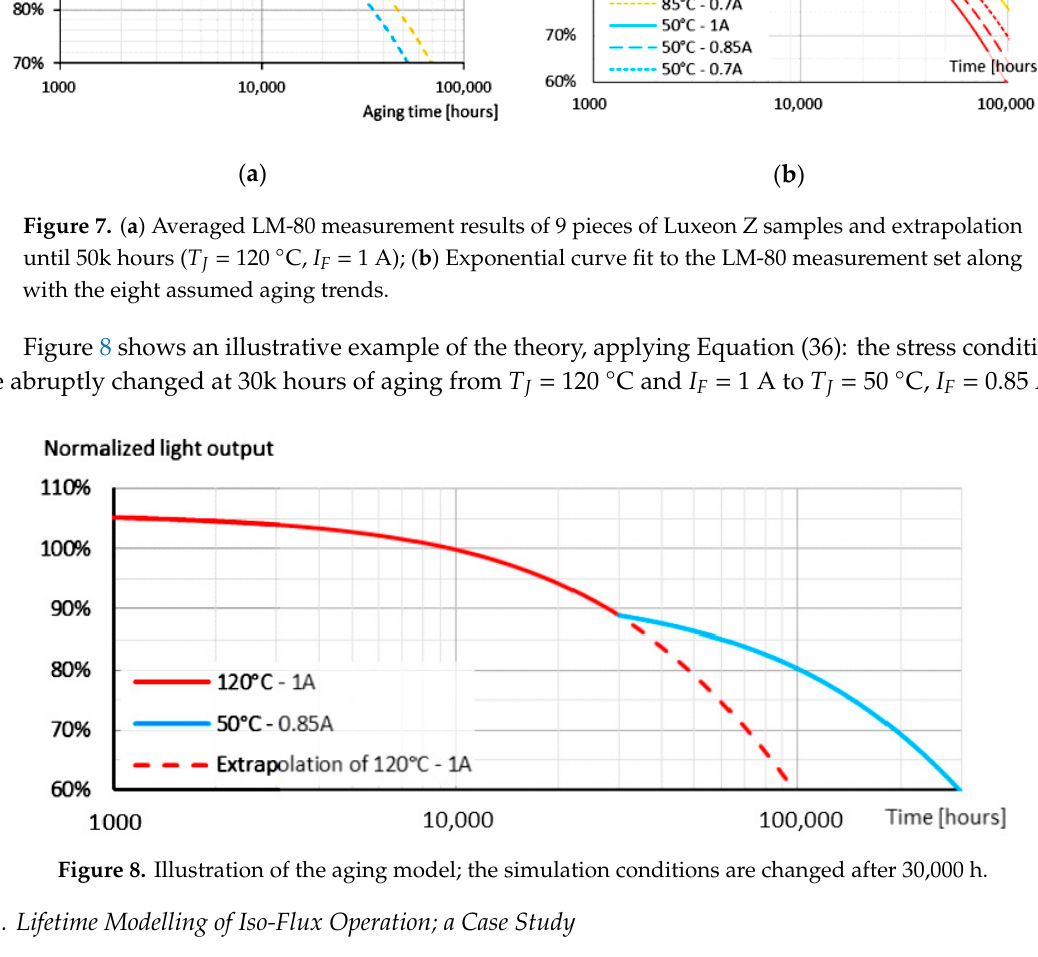
Figure 8. Illustration of the aging model; the simulation conditions are changed after 30,000 h.